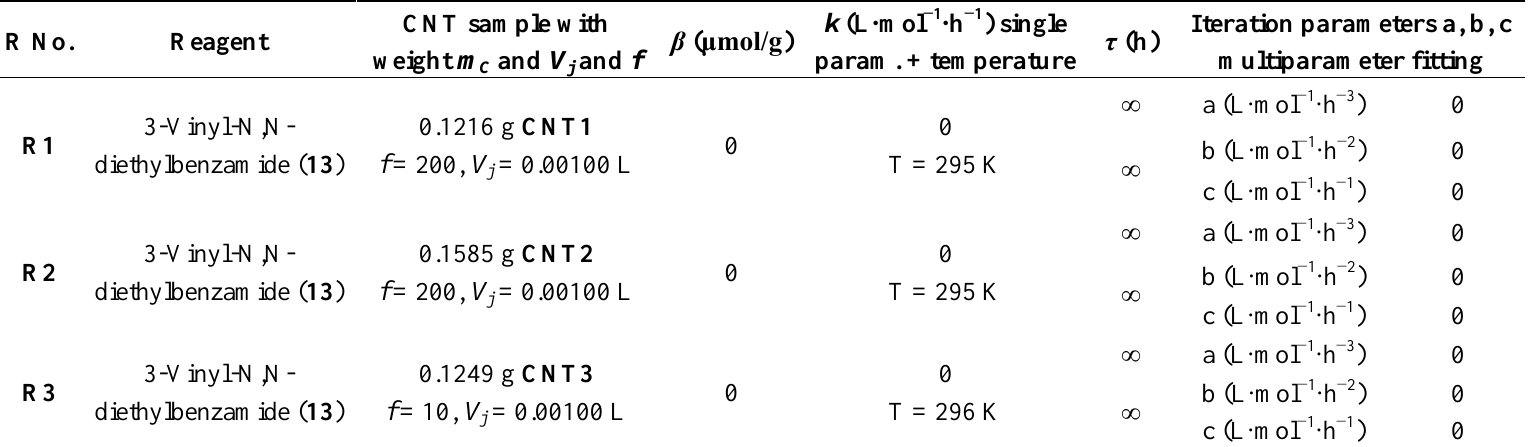
Iteration parameters a, b,